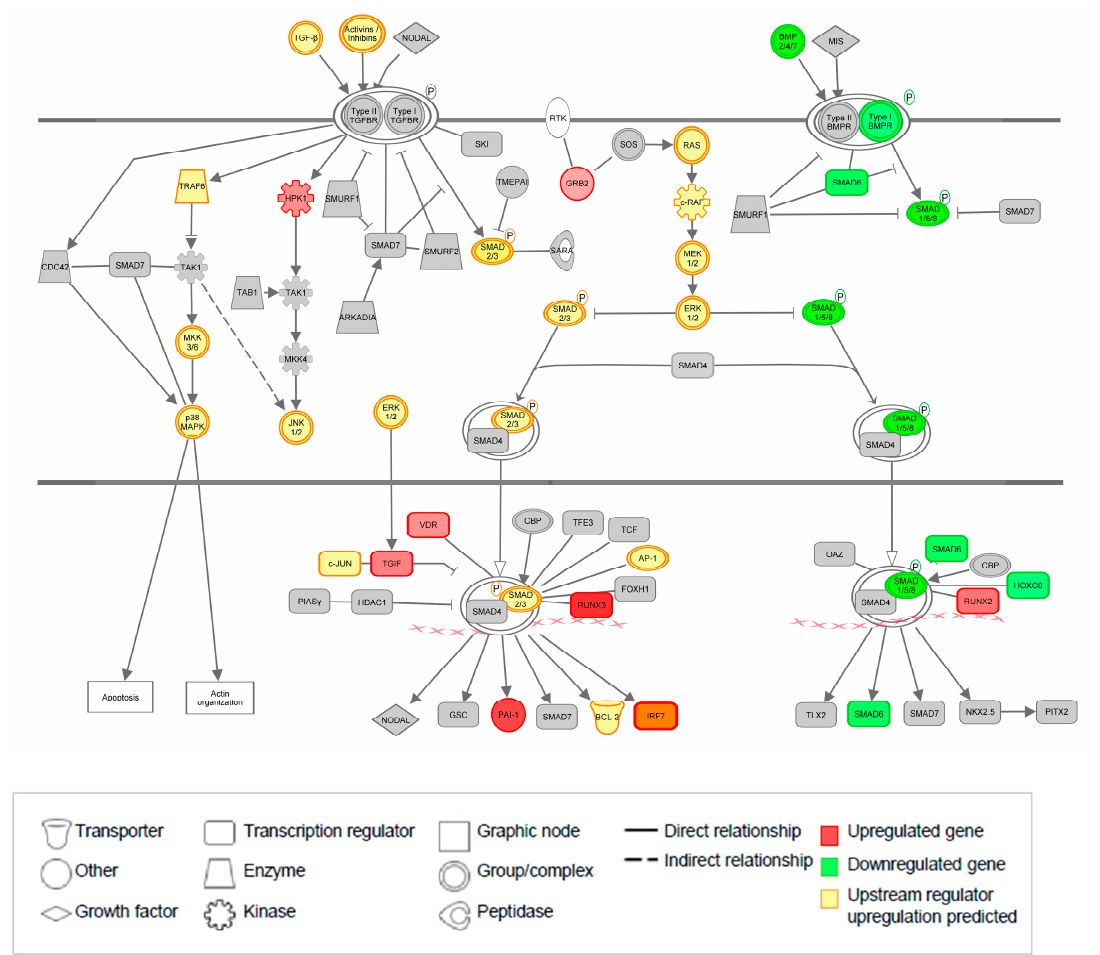
Figure 5. TGF- β signaling pathway with mediators in the TGF- β pathway and BMP pathway are depicted, adapted from IPA. Upregulated genes in red, down regulated genes in green, and upstream regulators which are predicted to be upregulated in yellow.